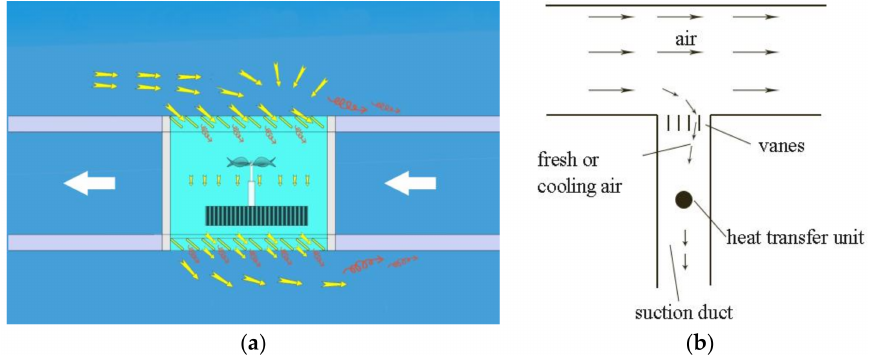
Figure 1. Abstract models of the ventilation and heat transfer units in the high speed train: ( a ) practical physical model; ( b ) simplified experimental